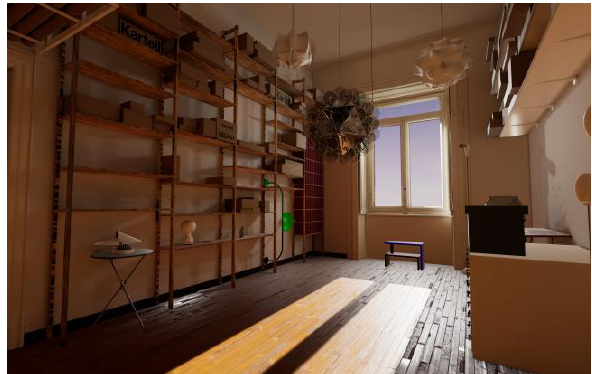
Figure 9. Virtual simulation: view of the Prototypes Room. To stimulate the visitor's interest and increase the sense of presence within the virtual museum, various interactive elements were created. The first type of interaction concerns the possibility to manipulate objects, which can be moved and analysed closely (such as Castiglioni's drawings, Diabolik's page and some of the design objects), and to interact with light sources.